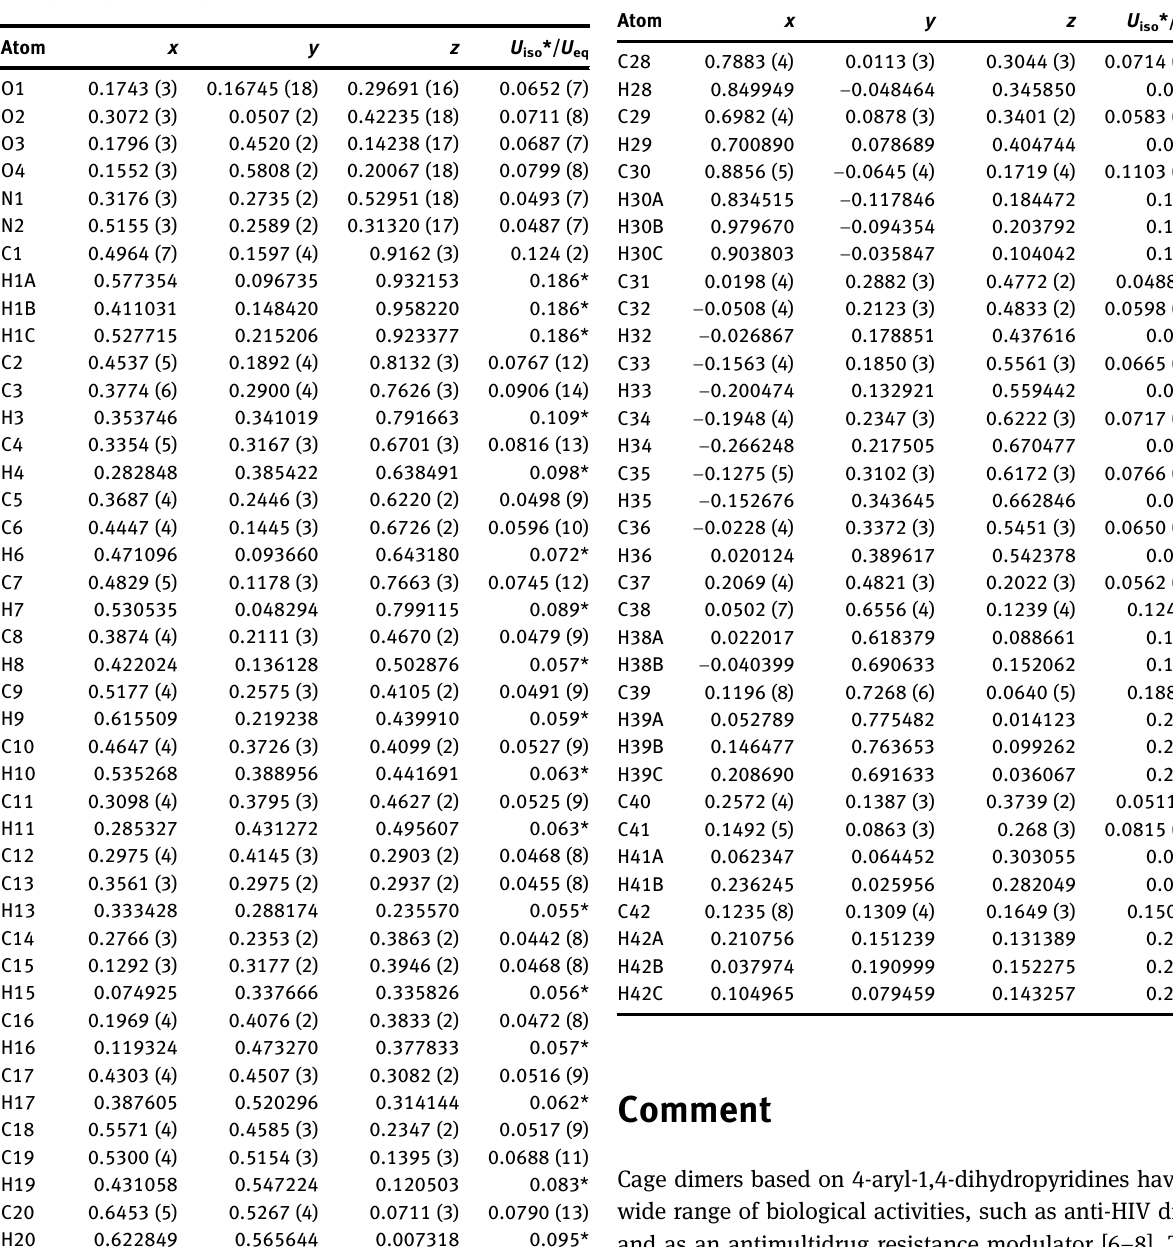
Table  : Fractional atomic coordinates and isotropic or equivalent isotropic displacement parameters (Å 